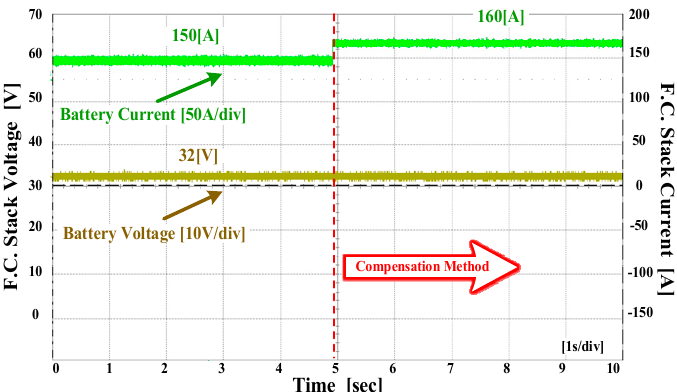
Figure 16. Output waveforms of lithium polymer battery during hydrogen recirculation.